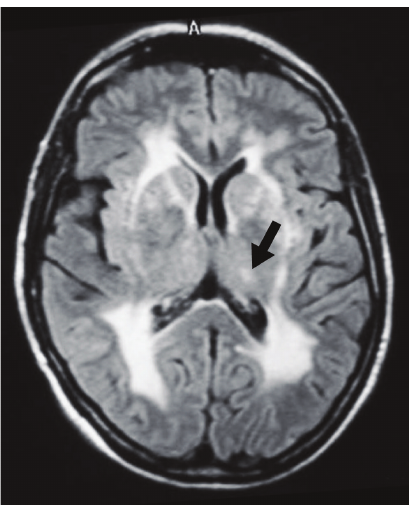
Figure 14: A patient with longstanding multiple sclerosis with diffuse leukoencephalopathy and a left thalamic demyelinating lesion (a) on FLAIR